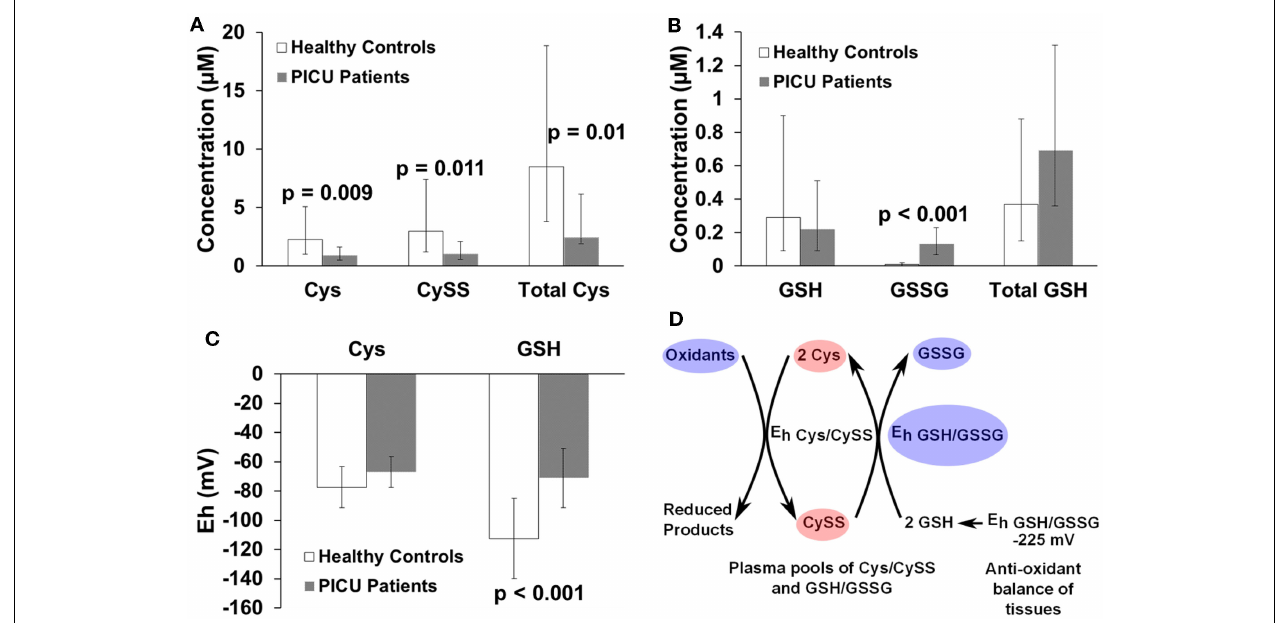
Jones et al. (16). The Total Cys concentration is higher than that of Total GSH. Because Cys is more abundant and more readily oxidized than GSH (as indicated by a less negative redox potential), Cys is preferentially oxidized to CySS in plasma. GSH in the plasma serves as a reducing pool to convert CySS back to Cys, thus maintaining the E h Cys/CySS in critically ill children nearly equal to that of healthy children. The redox balance of Cys is preserved by the supply of GSH from tissues. Red ovals represent a significant decrease in concentration of a metabolite. Blue ovals represent a significant increase in concentration of a metabolite or a more oxidized redox potential (E h ). Ovals are not representative of the magnitude of change and are not drawn to